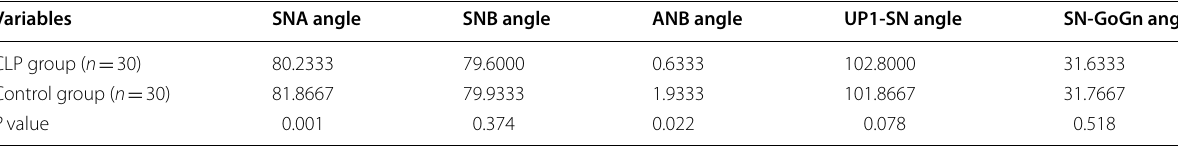
Table 1 Cephalometric craniofacial characteristics of CLP patients and non-cleft controls Variables